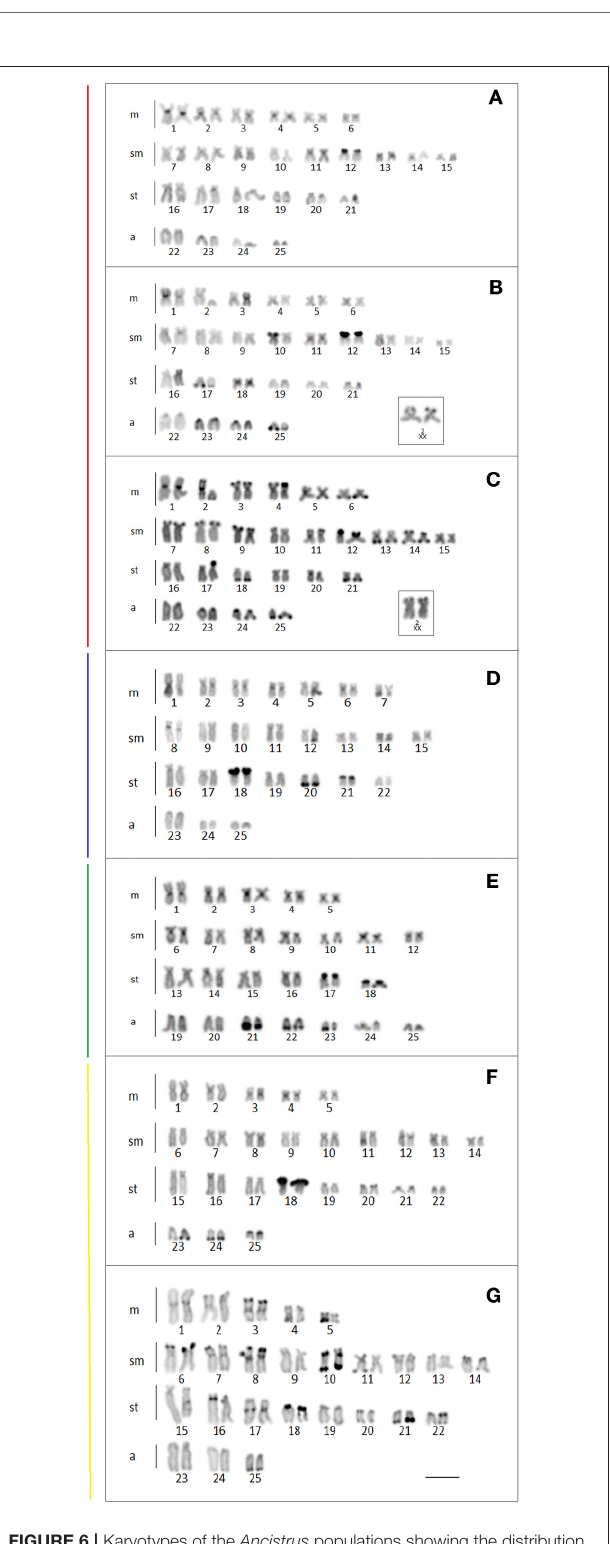
FIGURE 6 | Karyotypes of the Ancistrus populations showing the distribution of the heterochromatin after C-banding. Each color of the side bars represents one of the evolutionary lineages recovered in the analysis, according to Figure 2 . (A) L1, Mourão River; (B) L2, 19 Stream; (C) L3, Keller River; (D) L6, São Francisco Verdadeiro River; (E) L8, Ancistrus cirrhosus ; (F) L9, Ocoí River; (G) L10, São Francisco Falso River. Bar = 10 µ